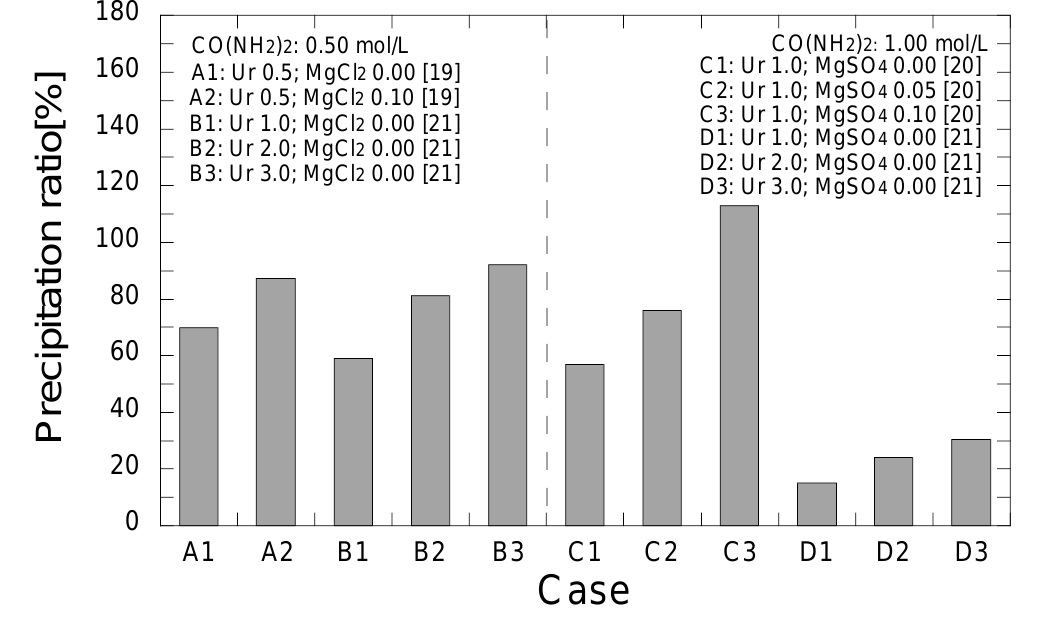
Figure 3. Summary of amounts of precipitated calcite [19 – 21].